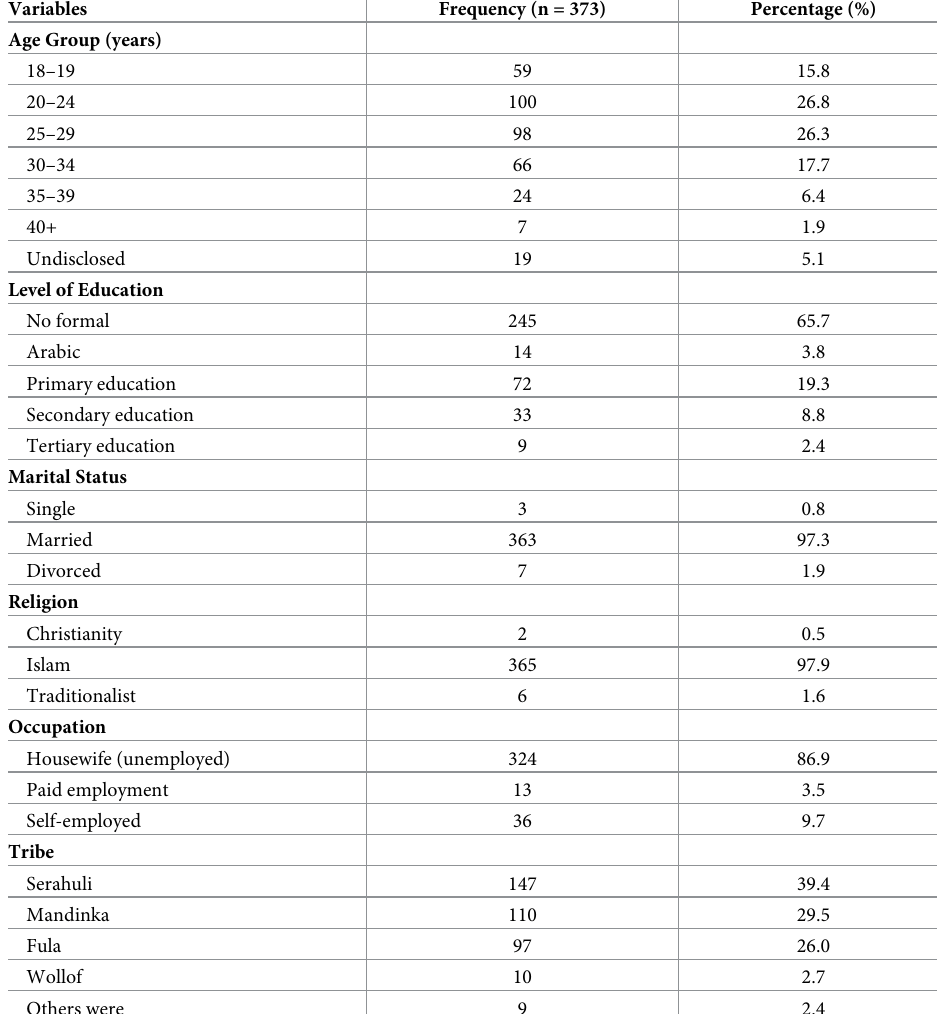
Table 2. Sociodemographic characteristics of the pregnant women seeking antenatal service at public health care facilities in the rural Gambia,